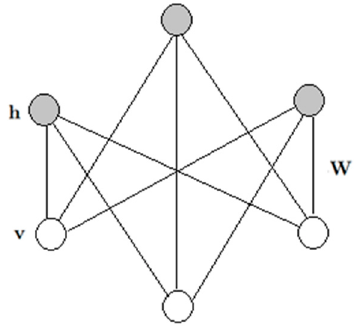
Figure 2. A restricted Boltzmann machine.